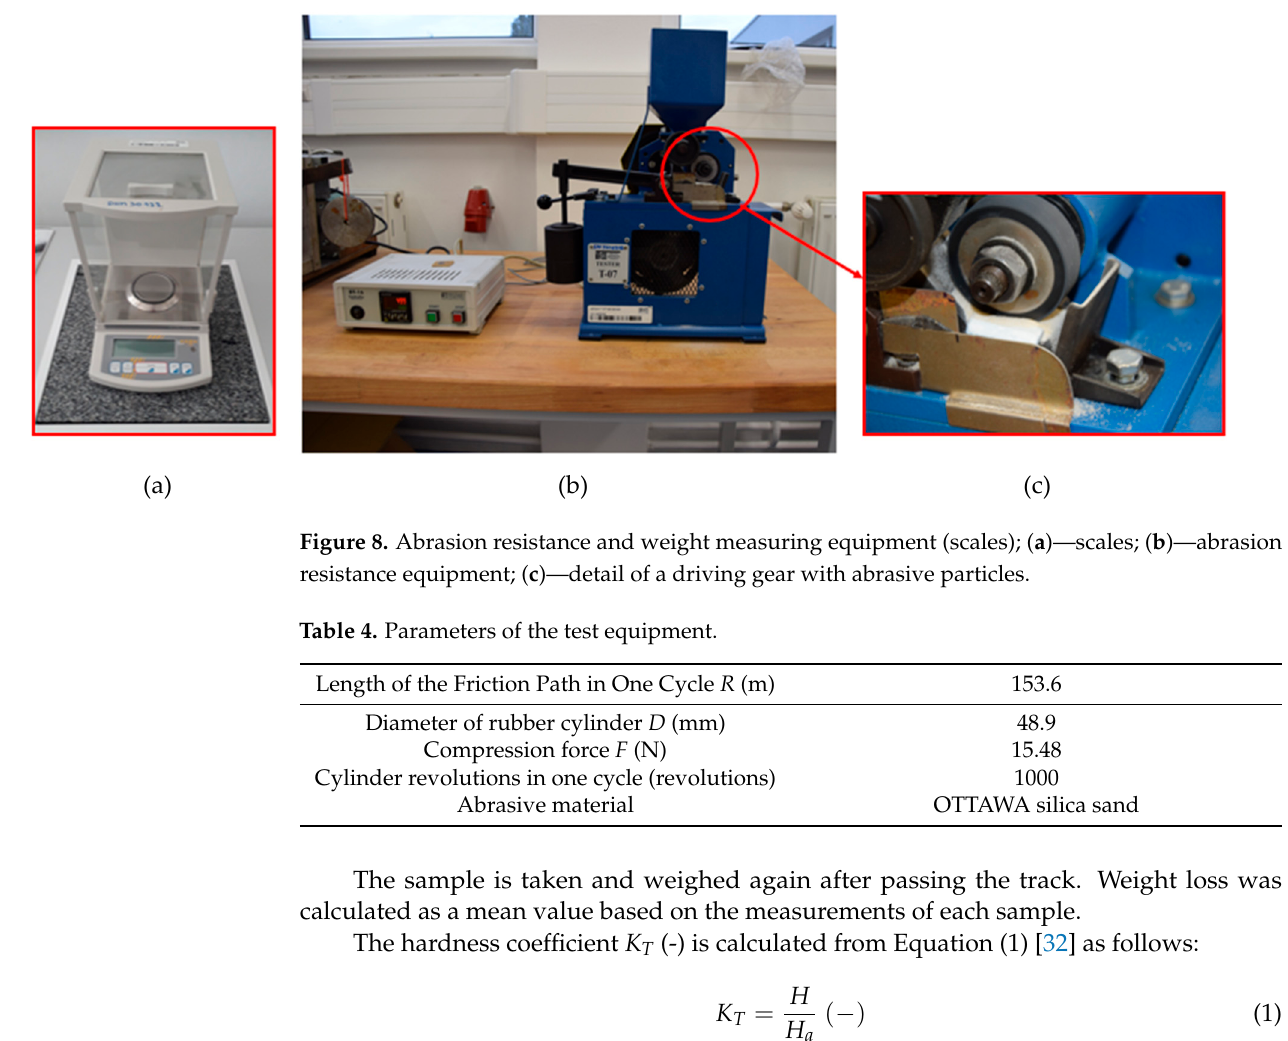
8 of 16 Figure 7. Scheme of the test equipment with a test sample [32].